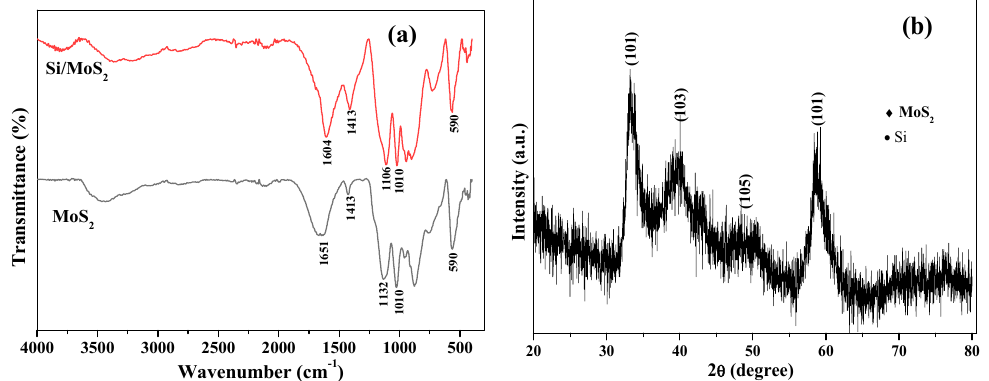
Figure 1. FT-IR spectrum of MoS 2 and Si / MoS 2 composite electrodes ( a ), and XRD pattern of Si / MoS 2 composite ( b ).